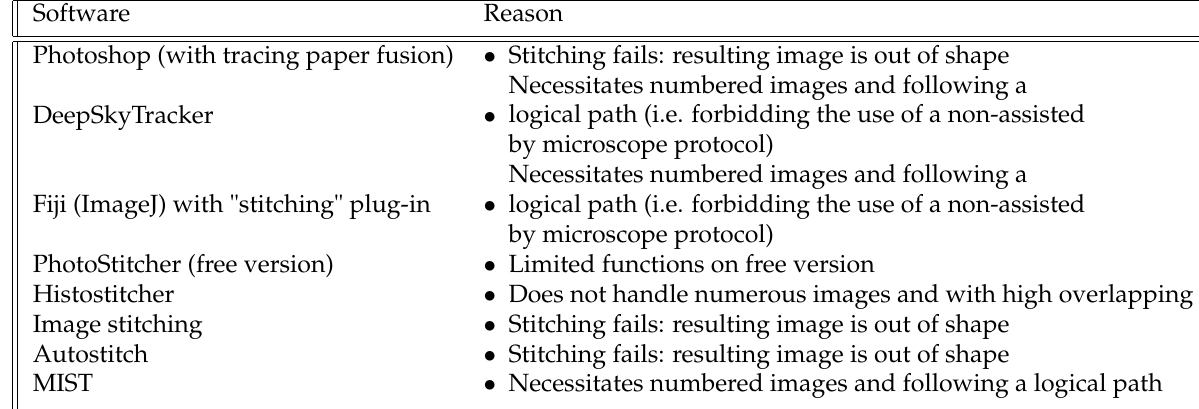
Table 3. Discriminated software products